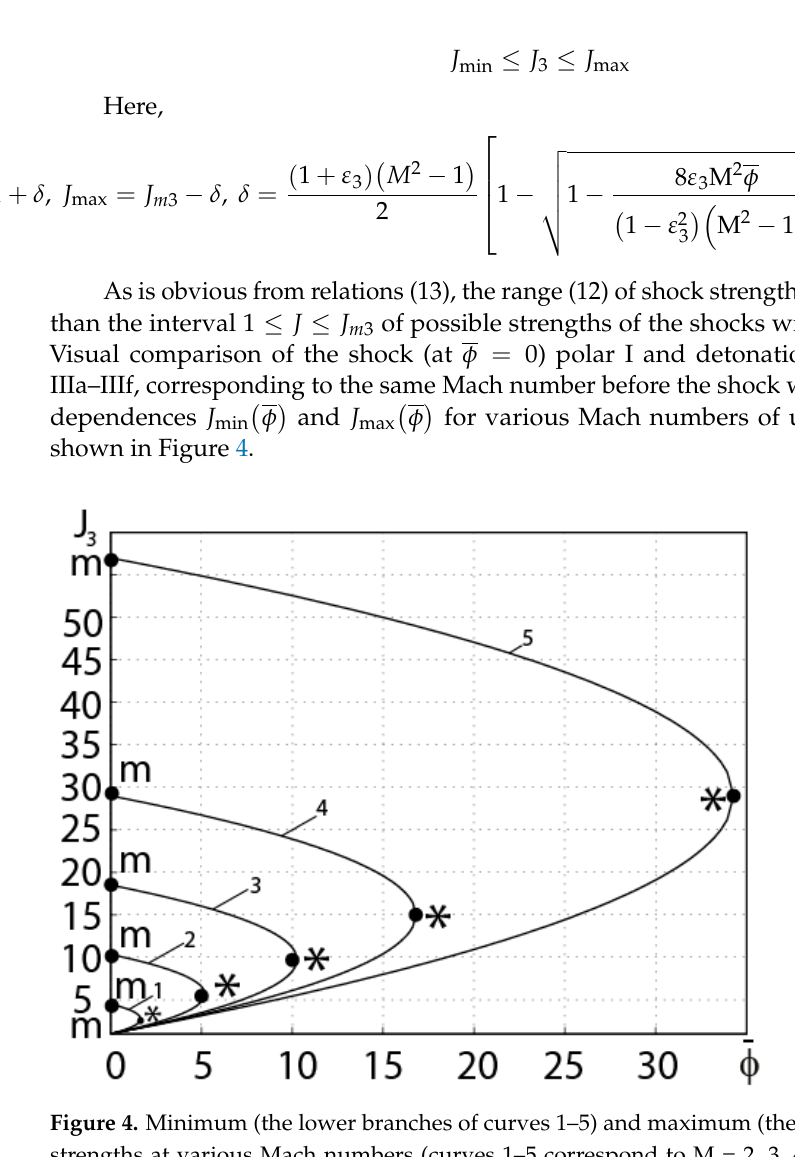
Figure 4. Minimum (the lower branches of curves 1–5) and maximum (the upper branches) shock strengths at various Mach numbers (curves 1–5 correspond to M = 2, 3, 4, 5 and 7). Curves “ ∗ ” correspond to the maximum pulsed energy release and to degeneration of shock polar to a single point (see Figure 2).